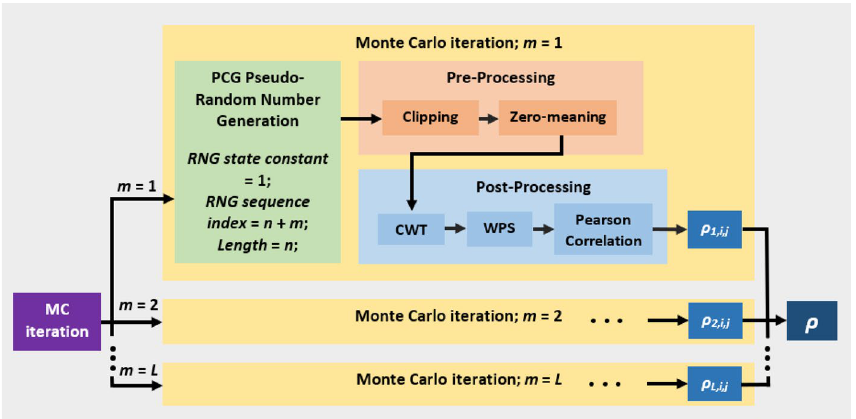
Figure 10. Diagram of MC data flow for determining white noise CWT-contribution inter-scale power correlation matrix.